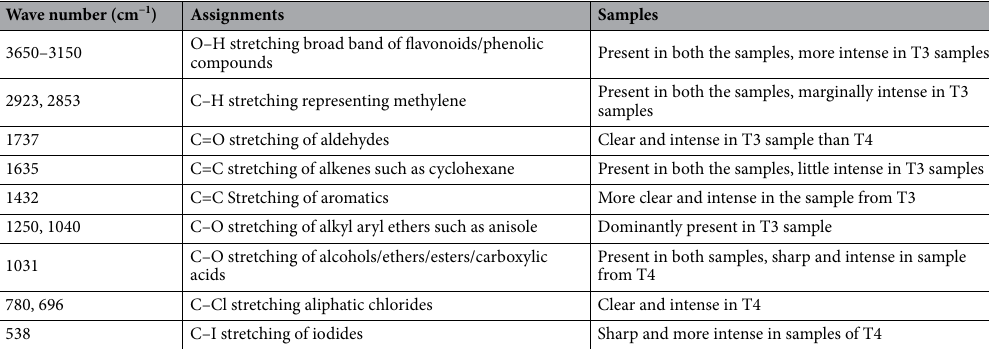
Table 4. Showing absorbance of IR spectra along with their assignments in the tested plant samples grown on T3 and T4 treatments. T3- Crude oil contaminated soil + Cyperus brevifolius ; T4- Non-contaminated soil + Cyperus